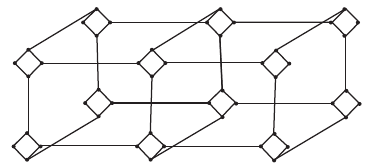
Figure 1: The hierarchical hypercube network ( HHC − 1 )